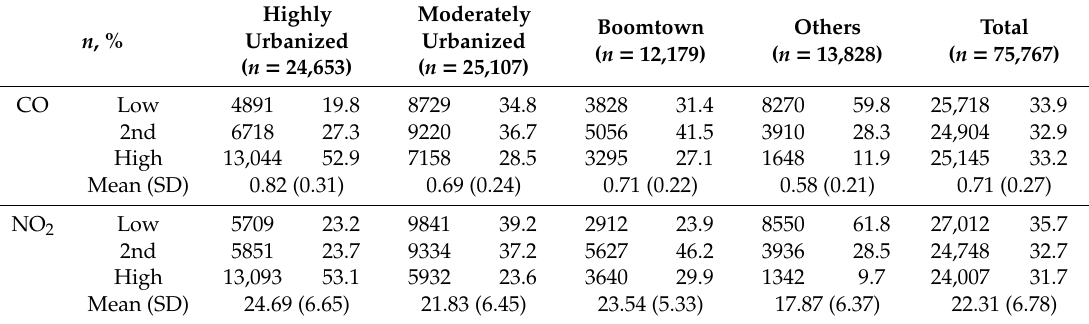
Table 3. Distributions of NO 2 and CO among urbanization